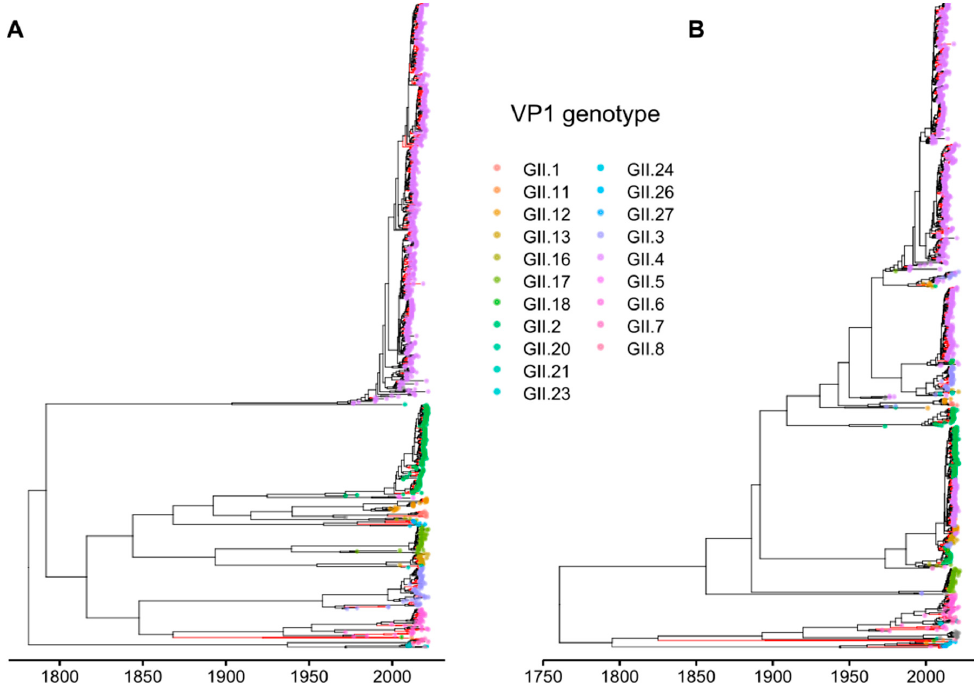
Figure 7. MCC trees of RdRp ( A ) and VP1 ( B ) genes on GII noroviruses. The scale bar represents time. Branches leading to matching subtrees in both trees are colored red. Bootstrap support was not indicated due to graphical considerations. The tree branches are colored according to the VP1